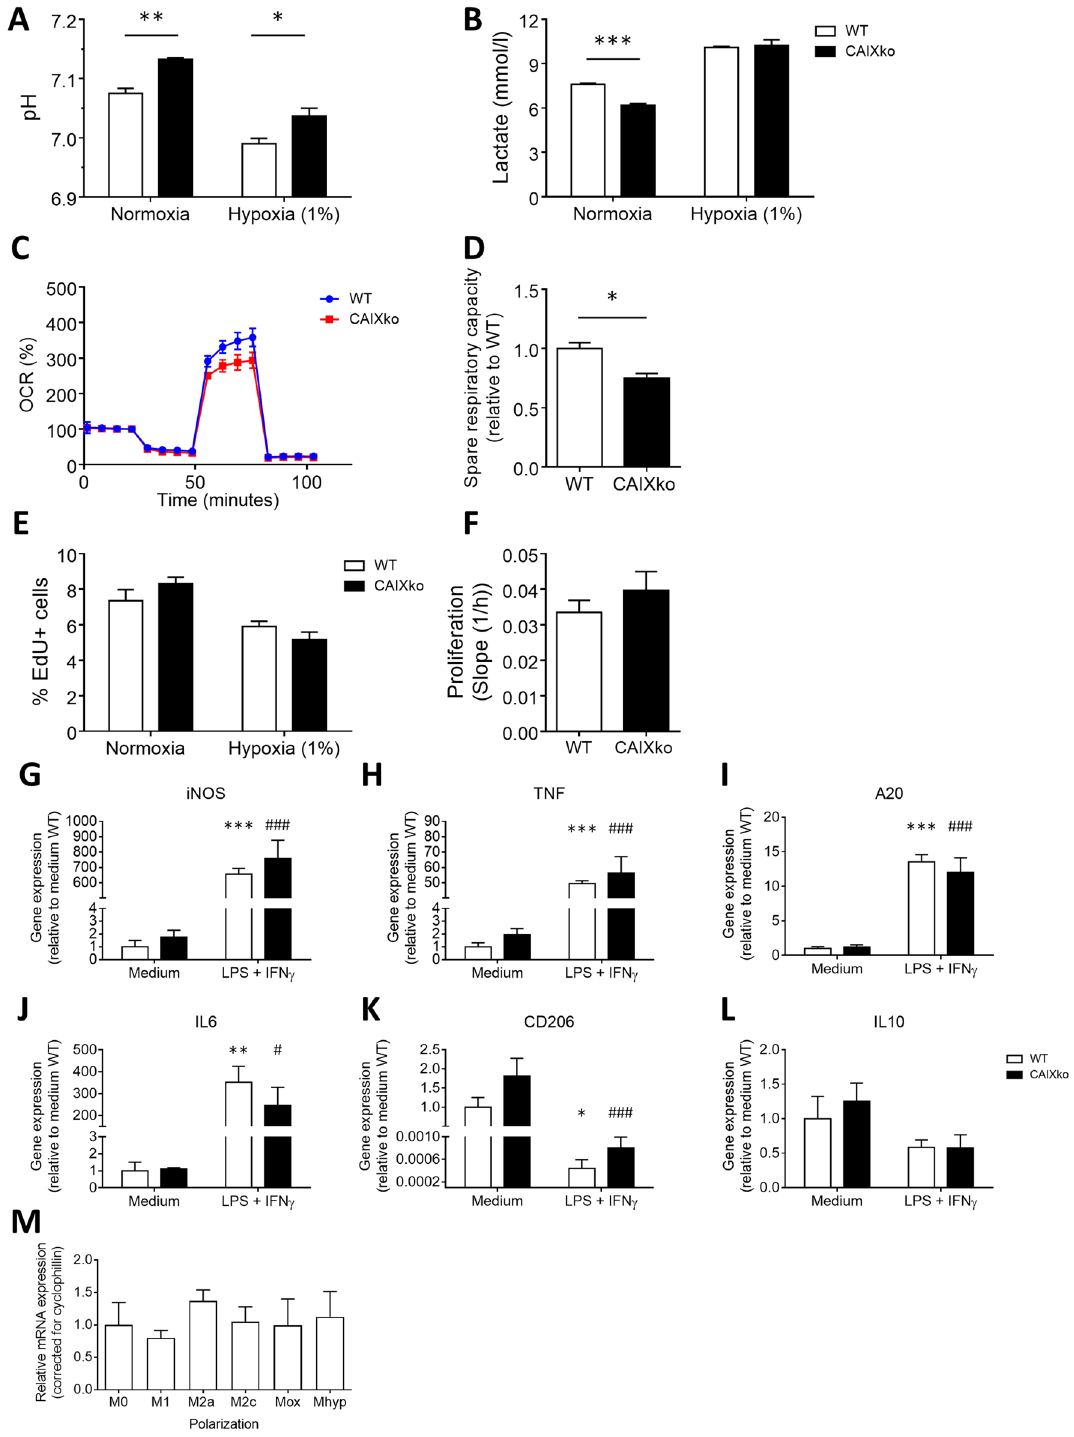
Figure 2. CAIXko reduced spare respiratory capacity in BMDMs. ( A ) pH and ( B ) lactate measurement of BMDM culture medium (n = 4) after 72 h of incubation in either normoxia or hypoxia (1% O 2 ). ( C ) Representative graph of Seahorse mitochondrial stress assay of BMDMs (n = 5/group, 1 experiments). Analysis was performed on data corrected for protein content in each well and with baseline measurement 4. ( D ) BMDM spare respiratory capacity displayed relatively to WT. ( E ) BMDM proliferation measured by EdU incorporation (n = 4) after 24 h incubation in normoxia or hypoxia (1% O 2 ). ( F ) Mean BMDM proliferation measured by real-time impedance (n = 5) over 72 h. Slope represents the increment of impedance over time. ( G ) Real time quantitative PCR of pro-inflammatory genes inducible nitric oxide synthase (iNOS), ( H ) tumor necrosis factor (TNF), ( I ) Tumor necrosis factor-induced protein 3 (A20) ( J ) interleukin 6 (IL6) and anti-inflammatory genes ( K ) mannose receptor (CD206) and ( L ) interleukin 10 (IL10) in non-stimulated (medium) and LPS + IFNγ stimulated BMDMs. All values are relative to WT unstimulated BMDMs of respective target gene. *Indicates a significant difference of stimulated WT compared to unstimulated WT BMDM. #Indicates significant difference of stimulated CAIXko compared to unstimulated CAIXko BMDMs. No difference was observed between WT and CIX-ko BMDM (white and black bars respectively). All results show mean ± SEM. * p < 0.05, ** p < 0.01, *** p <